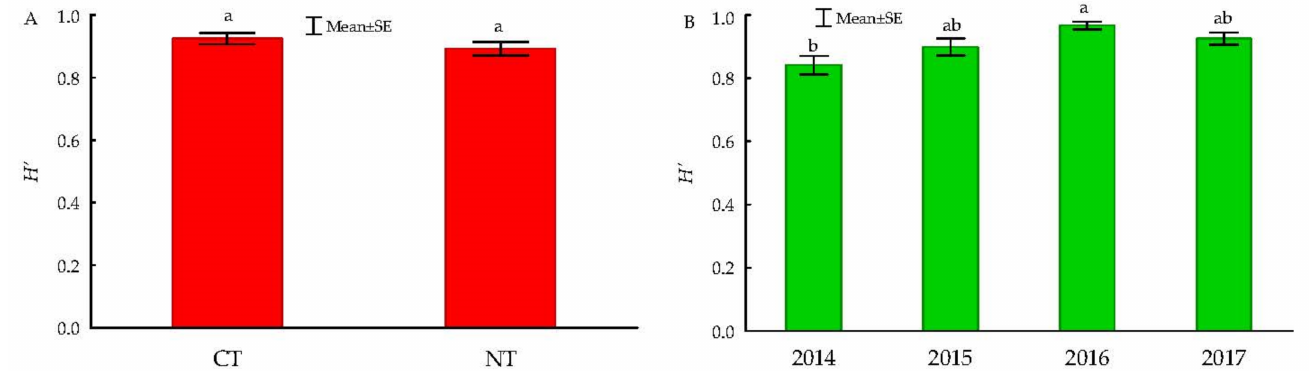
Figure 6. Shannon-Wiener’s diversity index (H’) of weed community in winter oilseed rape crop de- pending on the tillage system ( A ) (mean for 2014–2017)) and years of research ( B ). CT—Conventional tillage; NT—No-tillage. Different letters denote significant differences ( p ≤ 0.05). The same letter means not significantly different values.